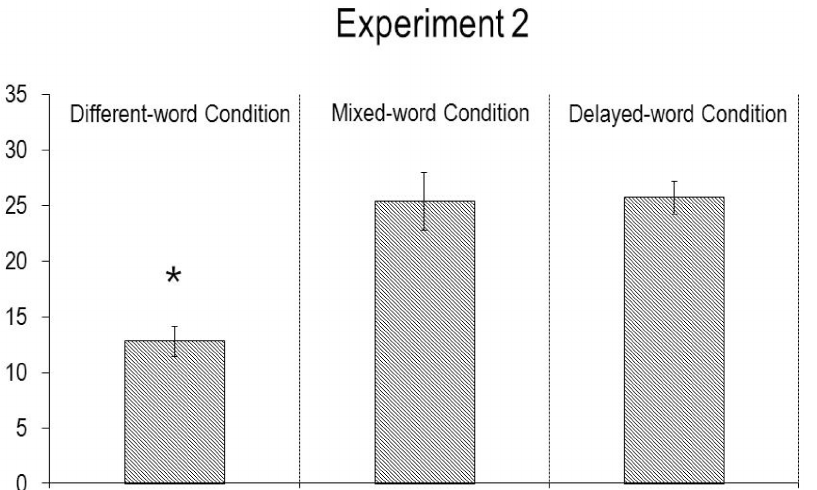
Figure 3. Mean looking times (s) of the infants in Experiment 2 during the test trial. Errors bars represent standard errors, and an asterisk denotes a significant difference between the conditions (p , .05 or better).